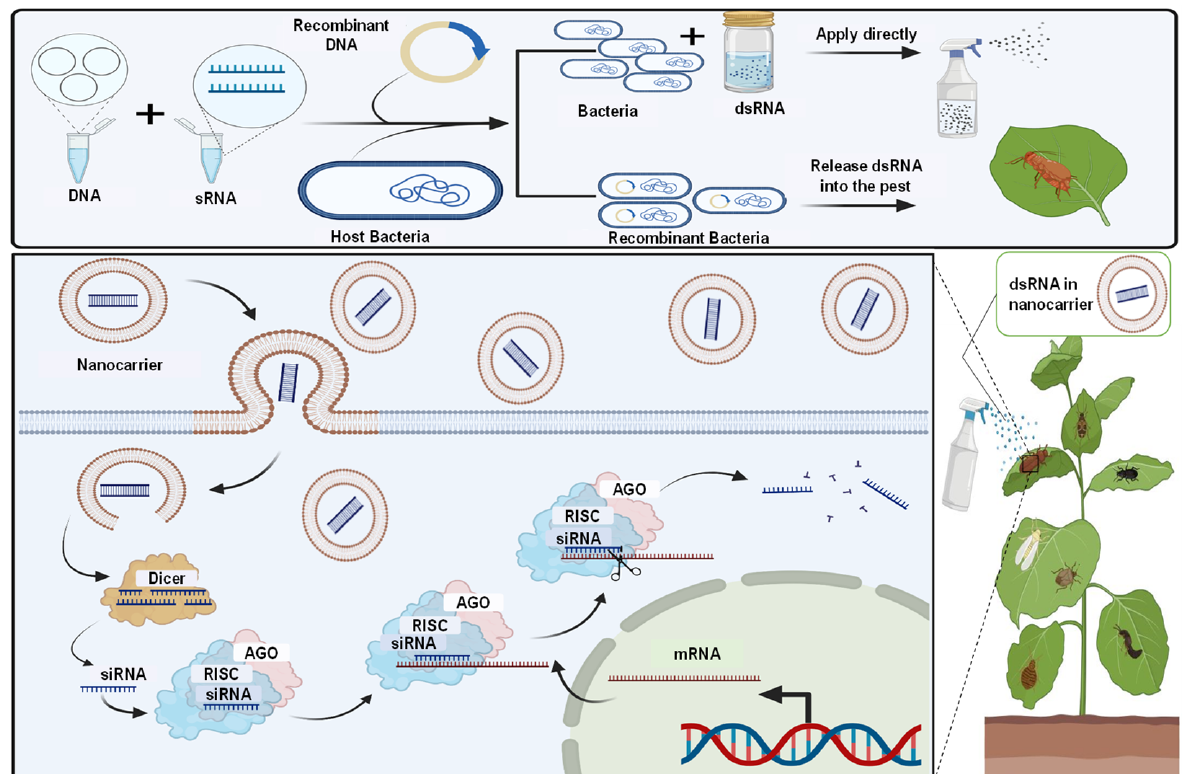
Figure 2. Microbial dsRNA production system and their technology to advance plant production. The dsRNA produced by microbes can be used directly for pest management by the nanocarrier ‐ based transdermal dsRNA transfer system, and spraying can aid in developing sprayable RNA pes ‐ ticides.